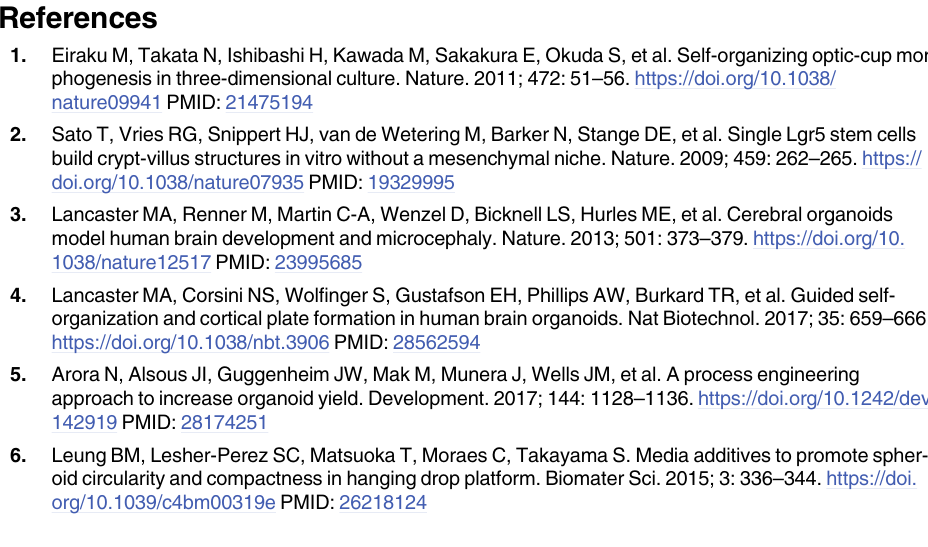
S1 Table. Time and Cost comparison of different embryoid body well-plate formation